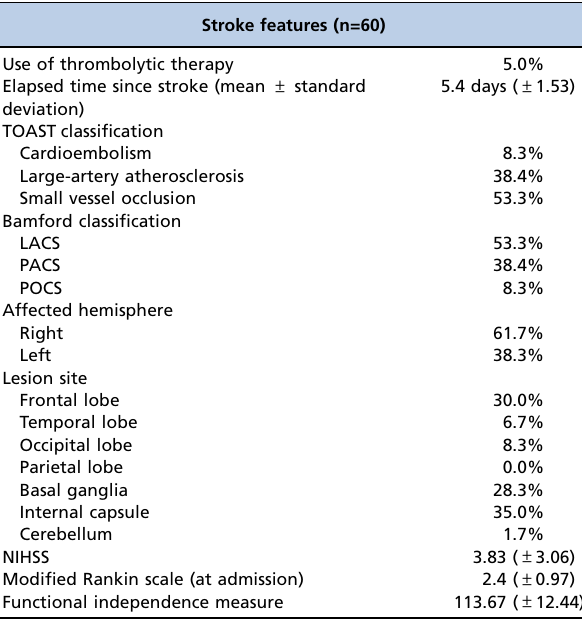
Table 4 - Psychiatric diagnosis established by the use of MINI- Plus in a sample of 60 patients after ischemic acute